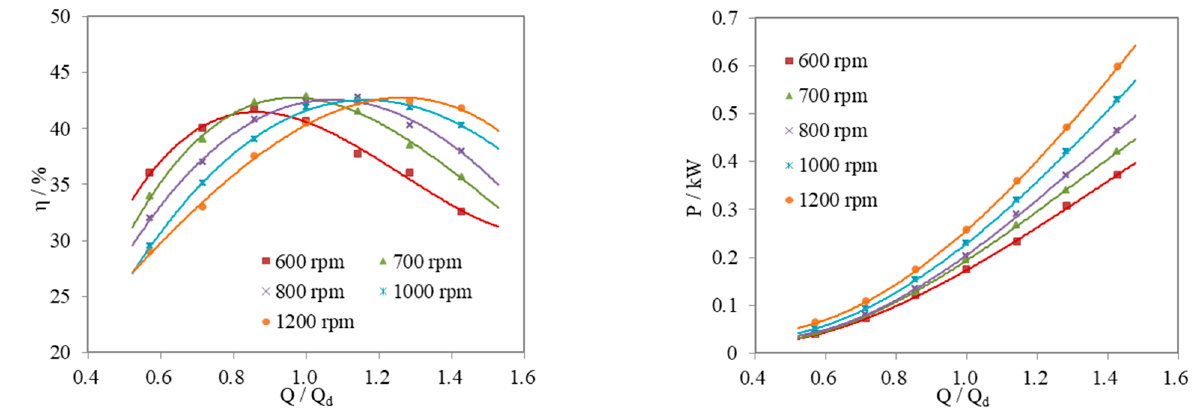
Figure 6. Hydraulic performances for the impulse water turbine.